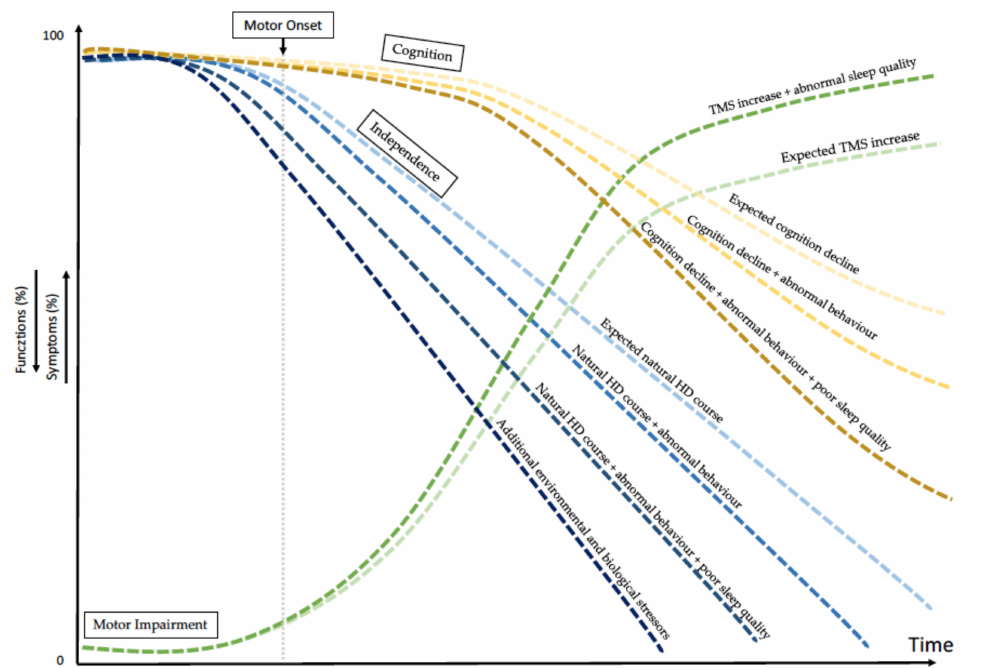
Figure 1. Variables affecting natural history of Huntington disease. The graph shows the simu- lated timing of HD progression due to the abnormal quality of patients’ sleep together with ad- ditional stressors, potentially affecting the natural HD history (i.e., biological and environmental factors). Among biological factors are intra- and extra- HTT gene modifiers. Among environmental factors are education, cognitive reserve and quality of sleep. All together, these several factors affect motor and cognitive declines separately or in combination and affect patients’ behaviour. TMS = Total Motor